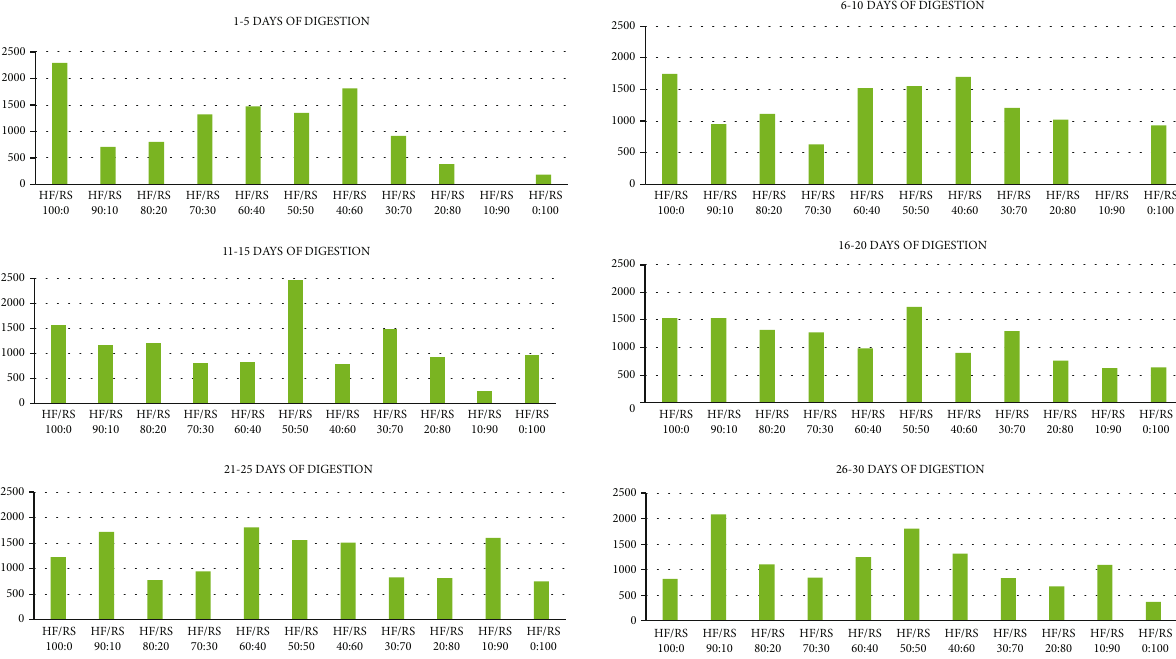
Figure 1: Overview of daily biogas yield from di ff erent combinations of HF and